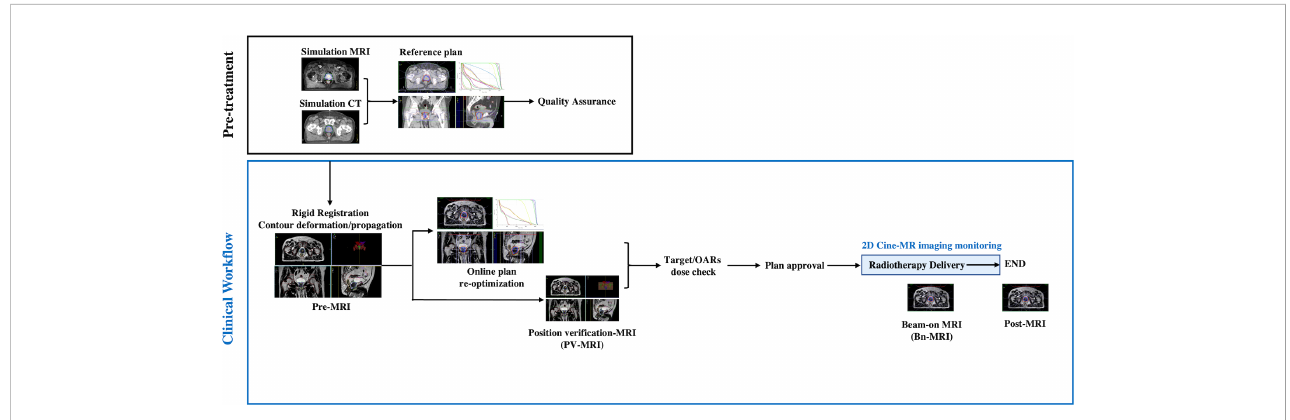
FIGURE 1 Pre-treatment and clinical work fl ow. Simulation MRI, MRI acquired for reference plan; usually scanned 1 to 2 weeks before treatment; Pre-MRI, MRI acquired each treatment day for adaptive plan optimization; OARs, Organs at risk; PV-MR, Position veri fi